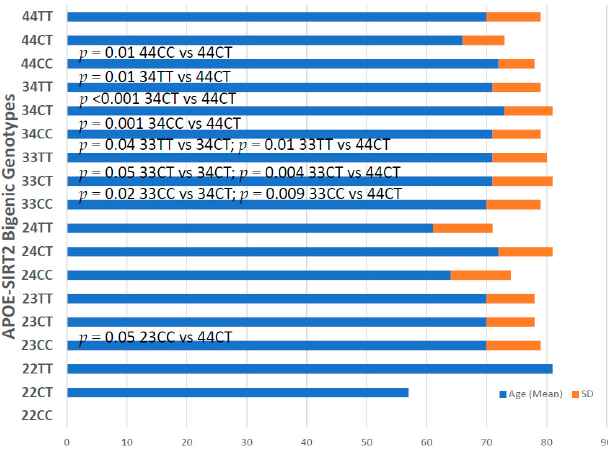
Figure 8. APOE-SIRT2 bigenic genotype-related differences of age at onset in Alzheimer’s disease.